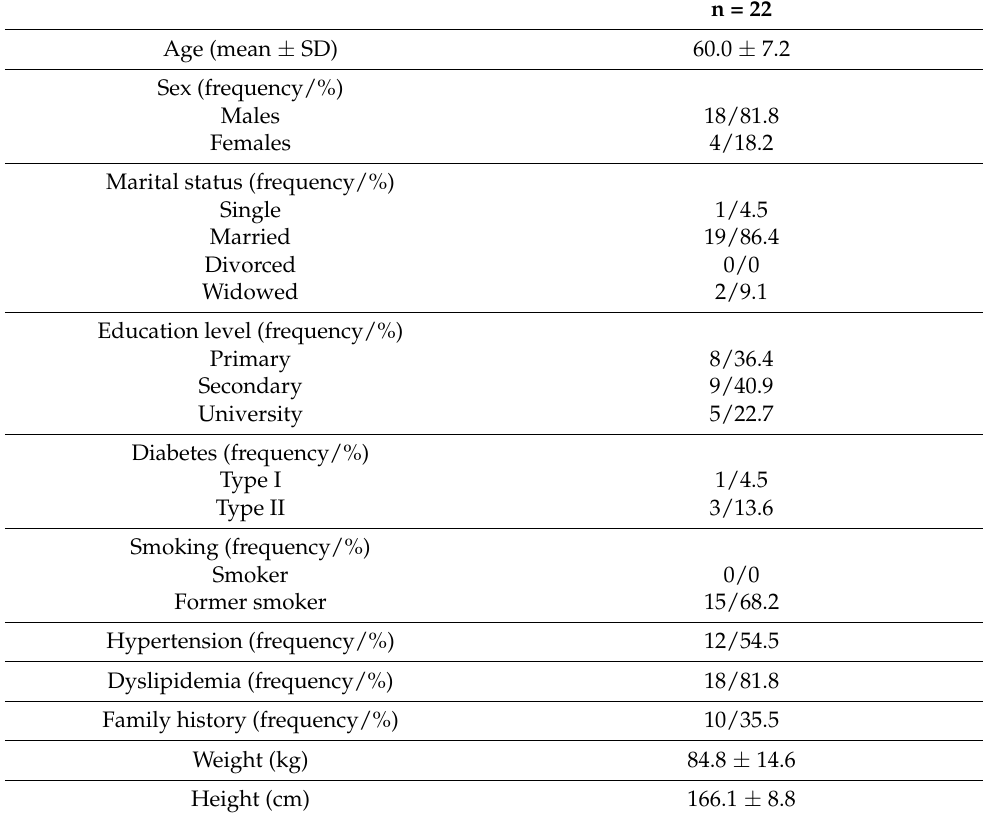
Table 1. Demographic and clinical characteristics of the